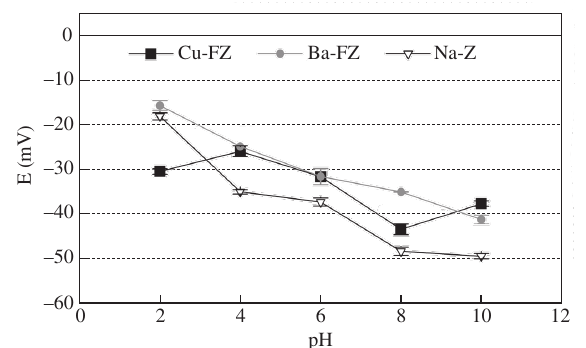
Figure 7. Zeta potential of the natural zeolite. Experimental error: ± 0.7 mV.